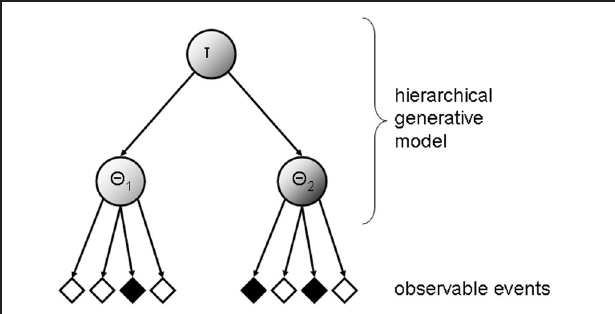
FIGURE 1 | Illustration of a hierarchical generative model of observed sensory data. The inferred probability structure of underlying states of the world is hierarchically represented, with τ signifying a state hyper-parameter, θ 1 and θ 2 , denoting dissociable state-specific parameters (just two levels of the hierarchy are drawn for